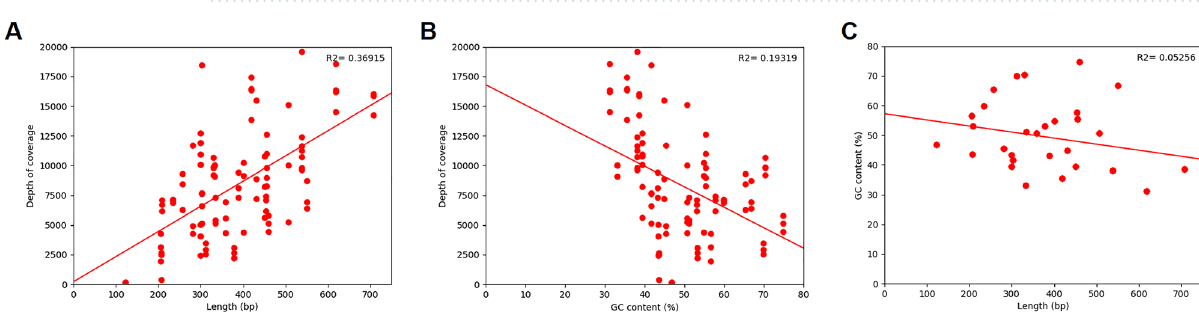
Figure 3. Alignment characteristics. ( A ) Each PCR amplicon is plotted (100 total), demonstrating a positive relationship between the length of the product and depth of coverage. ( B ) Each PCR amplicon is plotted (100 total), demonstrating a negative relationship between the GC content of the product and depth of coverage. ( C ) Length of amplicon compared to the GC content of each target region (30 total). The lack of significant relationship between these variables (R2 = 0.05256) indicates that each independently influences the depth of coverage of sequenced PCR